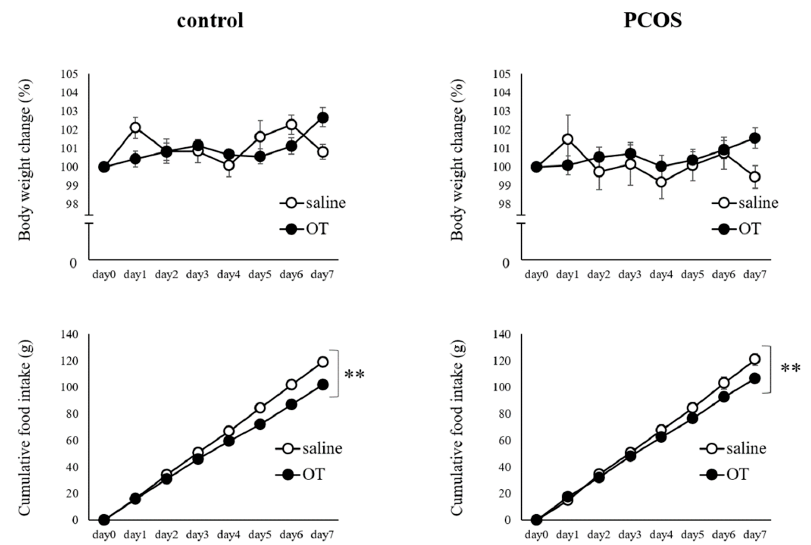
Figure 5. Body weight change (% initial body weight) and cumulative food intake during the 7 days of saline ( ○ ) or oxytocin ( ● ) administration in the PCOS and Control groups. Saline was intraperitoneally injected in the saline groups, and oxytocin (1200 μ g/kg) was intraperitoneally injected in the oxytocin groups at 2 h before the dark phase. Data are expressed as the means ± SEM. ** p < 0.01.